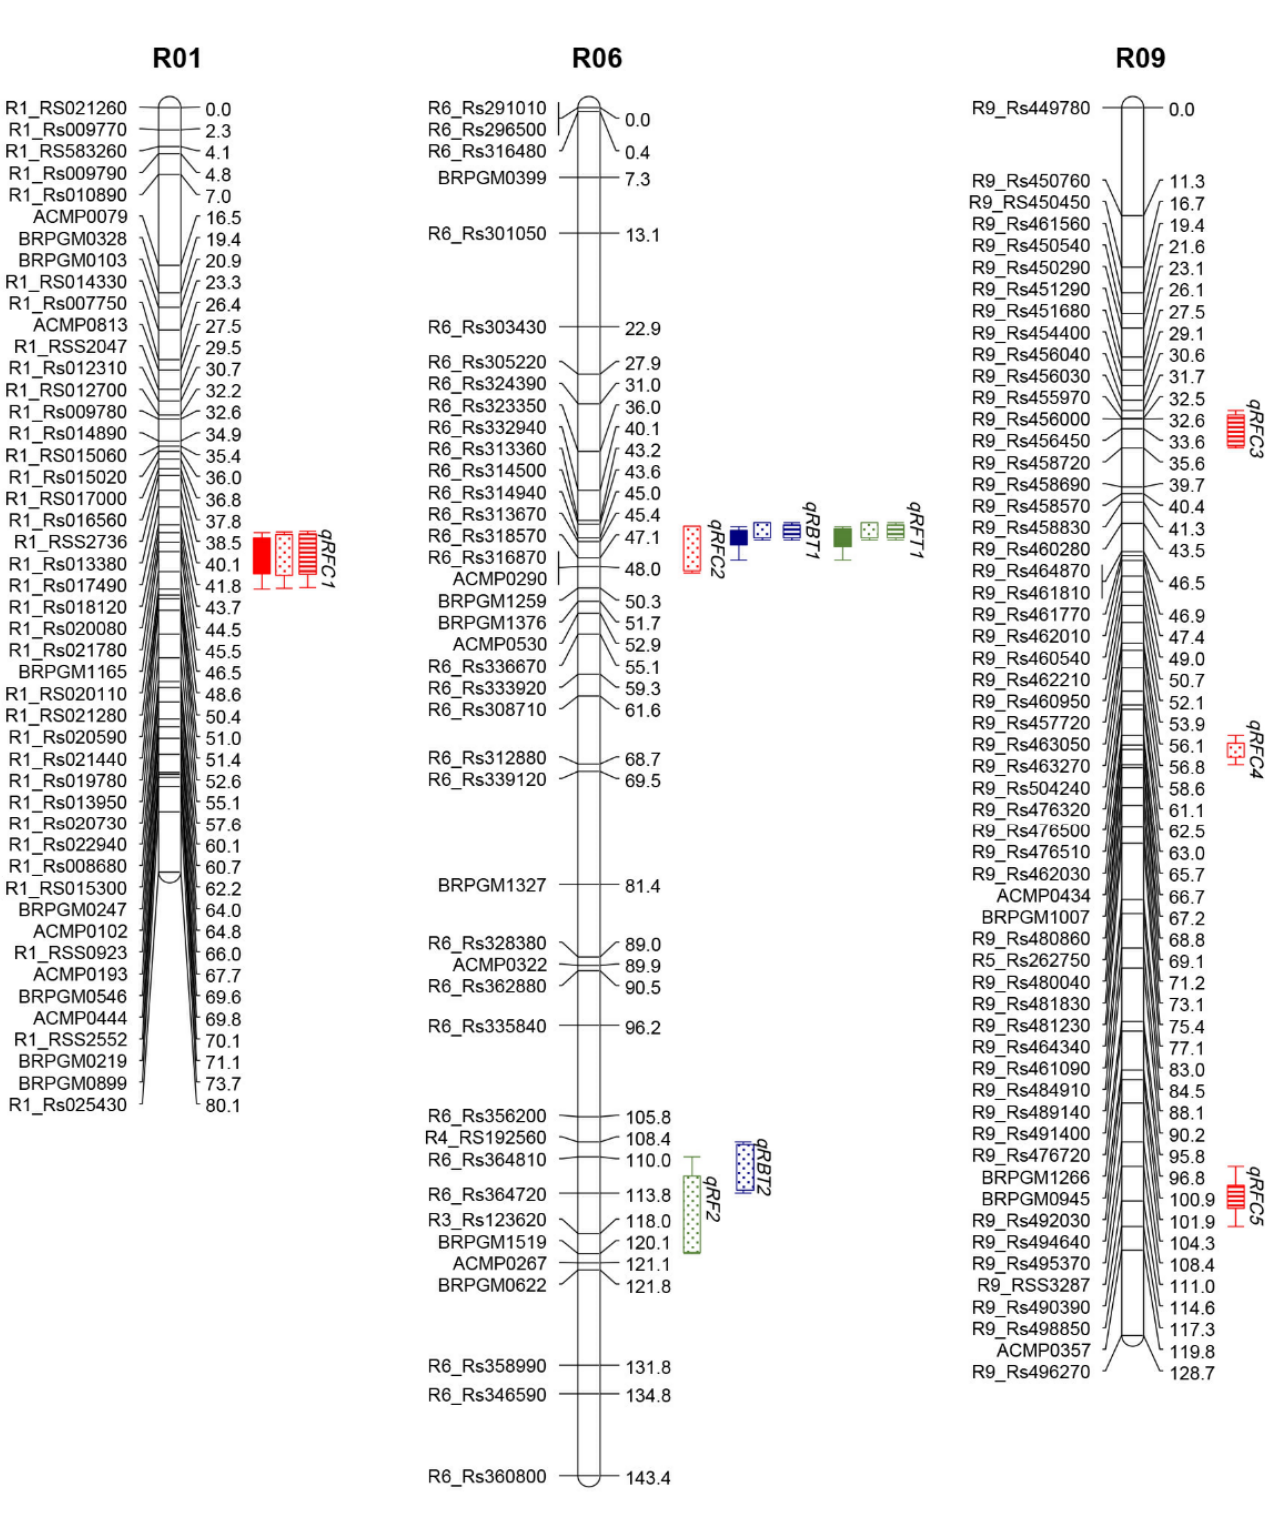
Figure 4. Genetic linkage map and distribution of QTLs for flower color, bolting time, and flowering time in the F 2 and F 2:3 populations. Markers are presented on the left side of the linkage group. Genetic distances are provided as centimorgans (cM) on the right side of the linkage group. The identified QTLs are indicated by abbreviated trait names on the right side of the linkage group. Red, blue, and green boxes represent QTLs for radish flower color, bolting time, and flowering time, respectively. Filled boxes represent the F 2 population in spring 2017, whereas dotted and lined boxes represent the F 2:3 population in spring and autumn 2018, respectively.